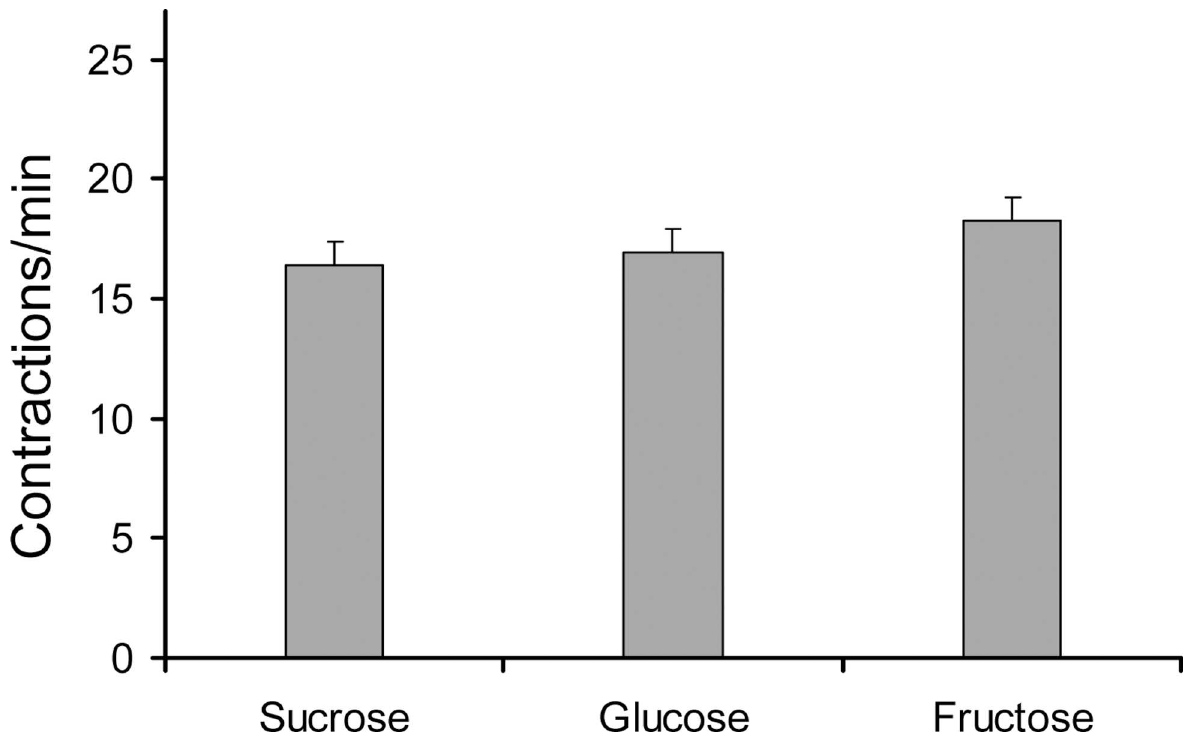
Fig 2. Effect of various sugars ingested and their influence on crop contraction rate in adult D . melanogaster . Mean values ± SE (vertical bars) from 20 insects (yw-1118strain) for each sugar tested. No significantdifferences were detected amongst the sugars ingested(P > 0.05; Tukey-Kramer test subsequent to